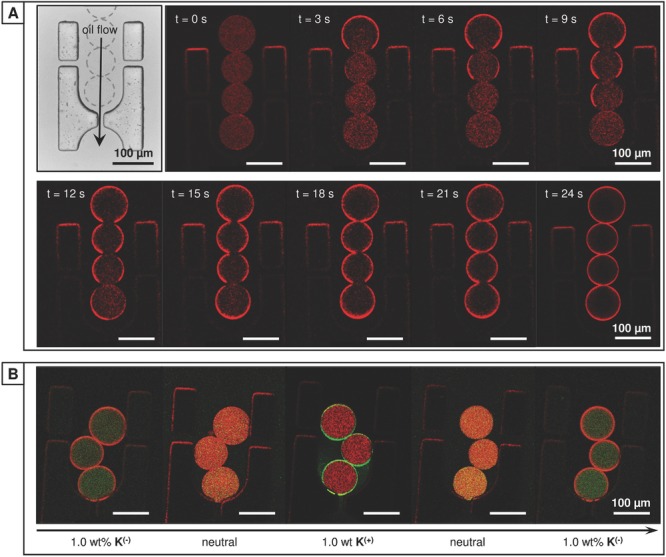
Dynamic control of charged copolymer within the microdroplet. A) Transmission image of the microdroplet trap (top left); aqueous microdroplets of rhodamine-labeled 2B(+) [MV = 60 × 10−6
m] were held within the trap by a continuous oil flow (250 μL h−1). Real-time laser-scanning confocal fluorescent images of the trapped microdroplets within a neutral oil flow. Upon switching to a complimentarily charged surfactant (1.0 wt% K(−)) rapid diffusion to the droplet interface was observed, with partitioning complete in 24 s. B) The location of orthogonally charged copolymers 1A(−) and 2B(+) [azo:MV = 60:60 × 10−6
m] can be independently manipulated within the microdroplet, allowing for selective assembly at the interface.